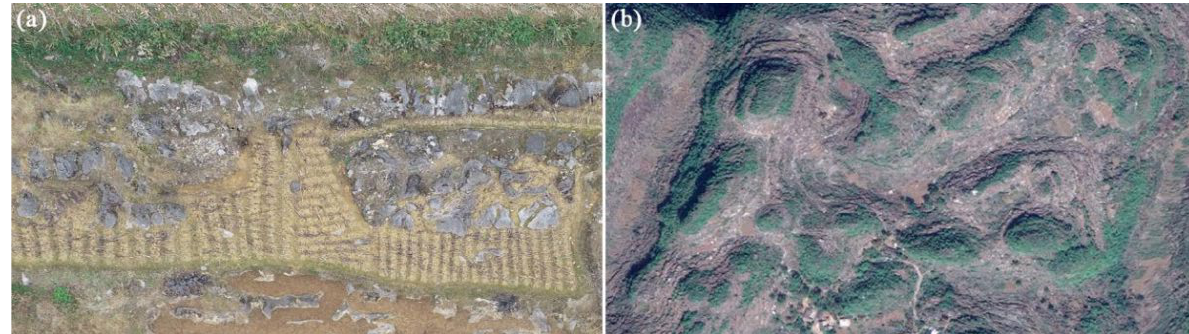
Figure 9. Actual view of the KRD area: ( a ) Different mosaic combination structures of soil patches and rocky exposed patches; ( b ) high heterogeneity and fragmentation in KRD landscapes.